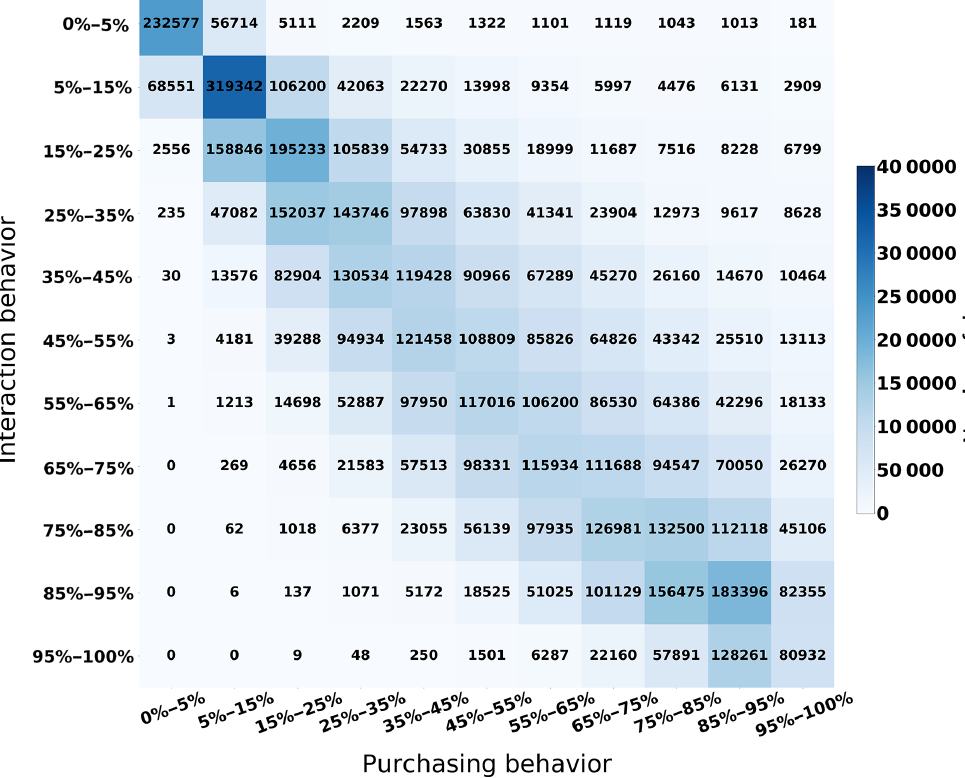
Fig. 7 Statistical heat map about the predictive results of six million users. Note: The axes represent two behaviors of users. directions respectively represent interaction